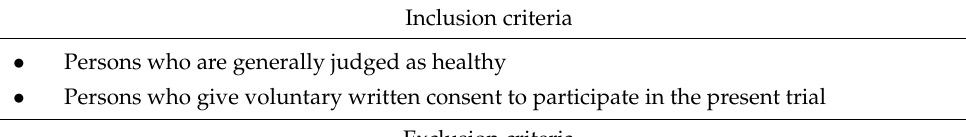
Table 2. Inclusion and exclusion criteria.